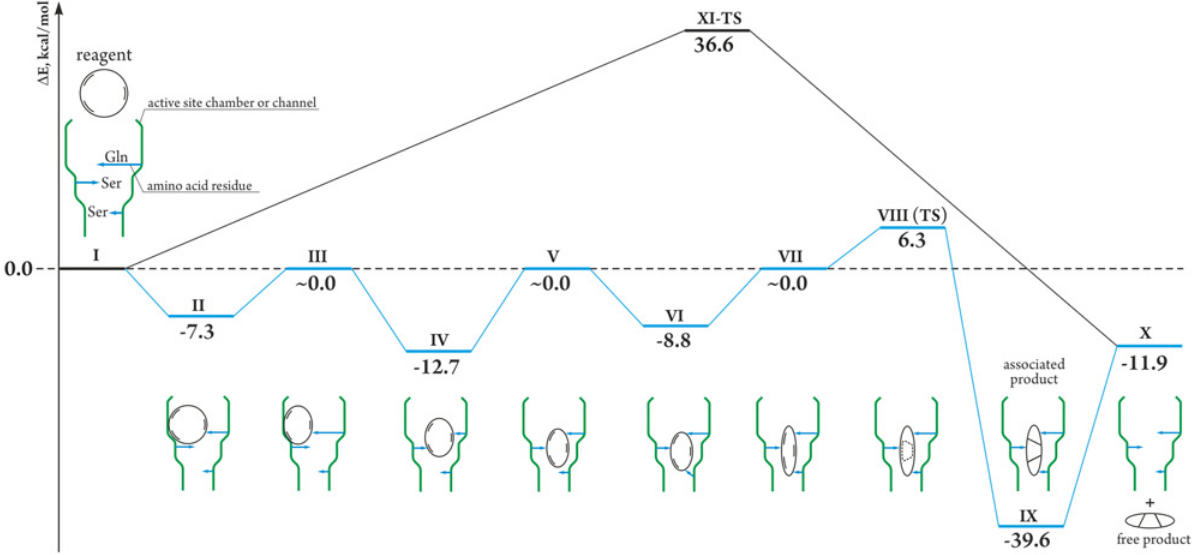
Fig 3. Comparison of regular and proposed cycloaddition reactions. Comparison of regular (black line) and proposed in the present study (blue line) cycloaddition reactions (calculated at the PM6 level). Coordination of amino acids and schematic substrate transformations are shown in the case of enzyme- catalyzed reaction (See S9 Fig and S10 Fig for structures and